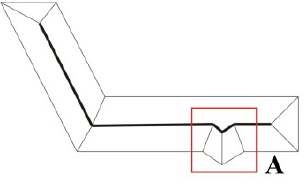
Figure 1. Straight skeletons.